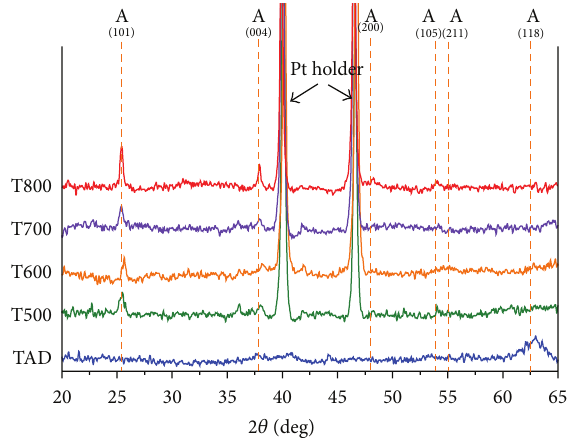
Figure 1: XRD patterns for as-deposited and annealed TiO 2 films.